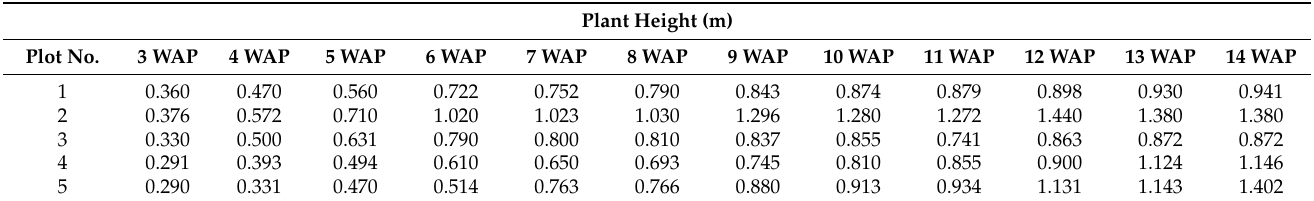
Table 1. Plant height at various stages of growth and different compaction treatments